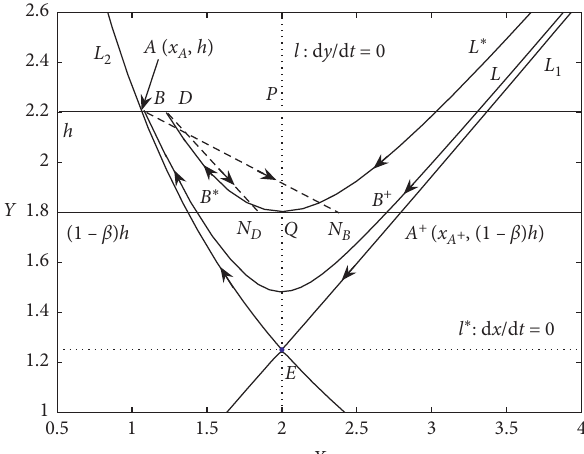
Figure 7: Trajectory L ∗ passing Q and impulse mapping D of case III with parameter values: a � 5 ,c � 4 ,d � 6 ,e � 3 , h � 2 . 2, and β � 0 . 2.